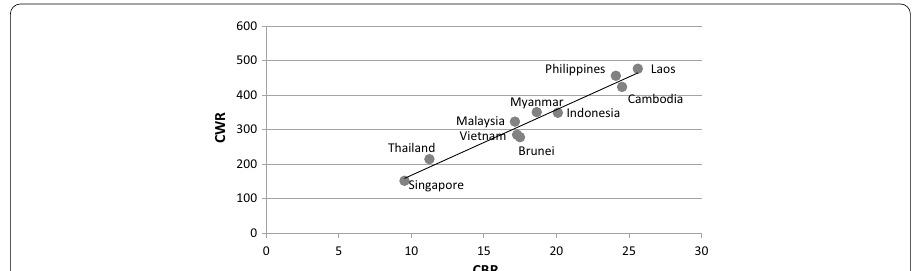
0.963, p < 0.001. Source: =